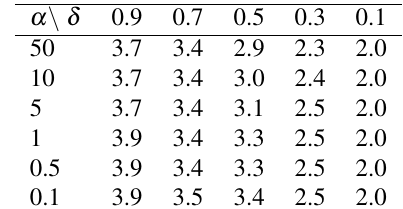
Table 2. Feature numbers as α and δ for Spam